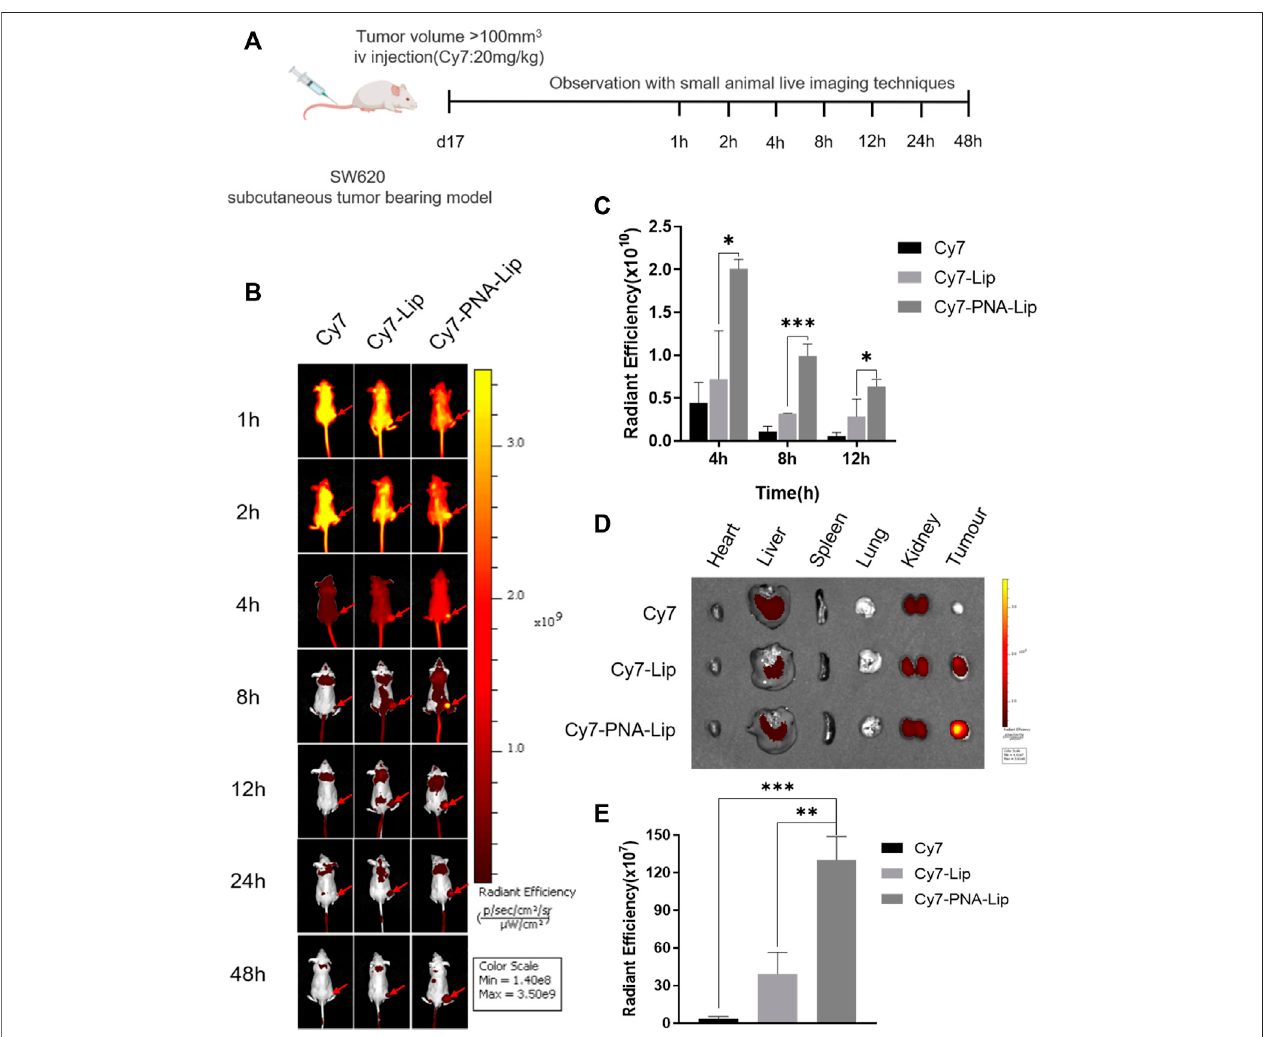
FIGURE 8 | PNA-modi fi ed liposomes exhibited effective MUC1-targeting properties in colorectal cancer tumors. (A) Design principles for the analysis of the targeting ability of PNA-modi fi ed liposomes in vivo . (B) Distribution of Cy7 in tumor-bearing nude mice after tail vein injection. (C) Quantitative histogram of fl uorescence signals at tumor sites at different points in time. (D) Distribution of Cy7 in vital organs and tumor tissues after 48 h. (E) Quantitative histograms of fl uorescence signals in tumors. The data are presented as the mean ± SD (n = 3). * p < 0.05. **p < 0.01. ***p < 0.001.